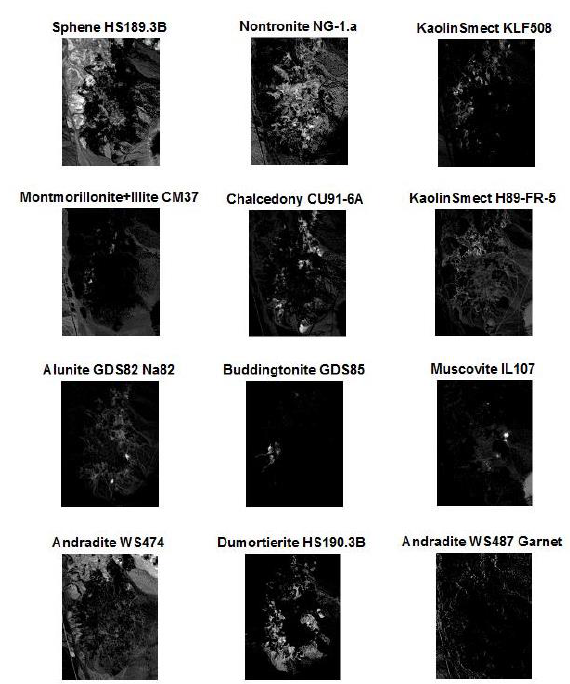
Figure 6. Fractional abundances of endmembers that are present in the